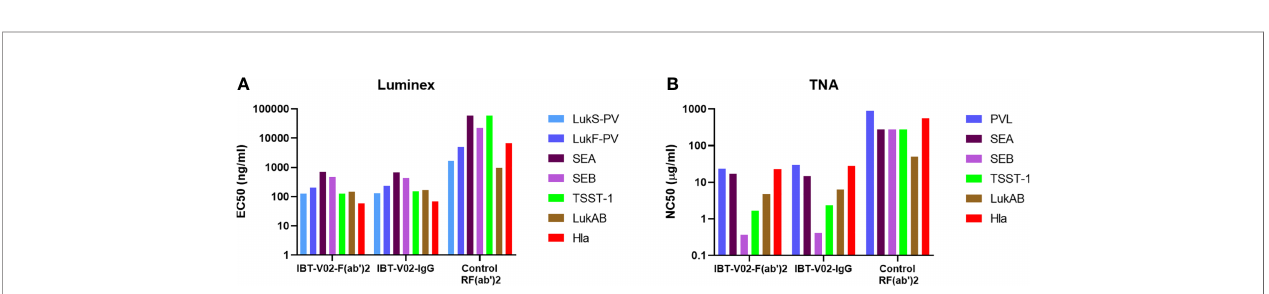
FIGURE 4 | Anti-Staph IBT-V02-F(ab ’ )2 and IBT-V02-IgG binding and neutralization potency were compared with the control RF(ab ’ )2. (A) Luminex binding titers were compared based on 50% effective concentration (EC 50 ) for seven antigens (components of IBT-V02), Hla, LukS-PV, LukF-PV, LukAB, SEA, SEB, and TSST-1. (B) Toxin neutralizing titers were compared based on 50% neutralizing concentration (NC 50 ) for six toxins, Hla, PVL (LukS-PV + LukF-PV), LukAB, SEA, SEB, and TSST-1.